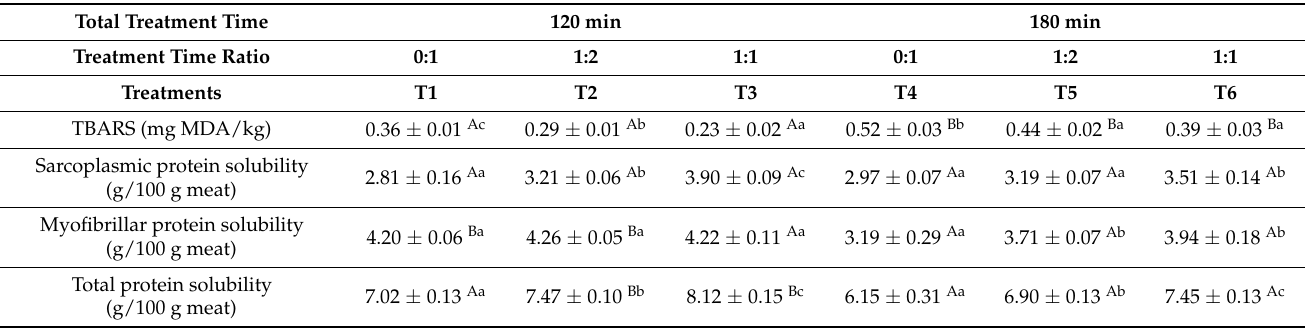
Table 6. Means ± standard deviations of TBARS and protein solubility parameters of sous vide- treated chicken breast with different combinations of temperatures and time